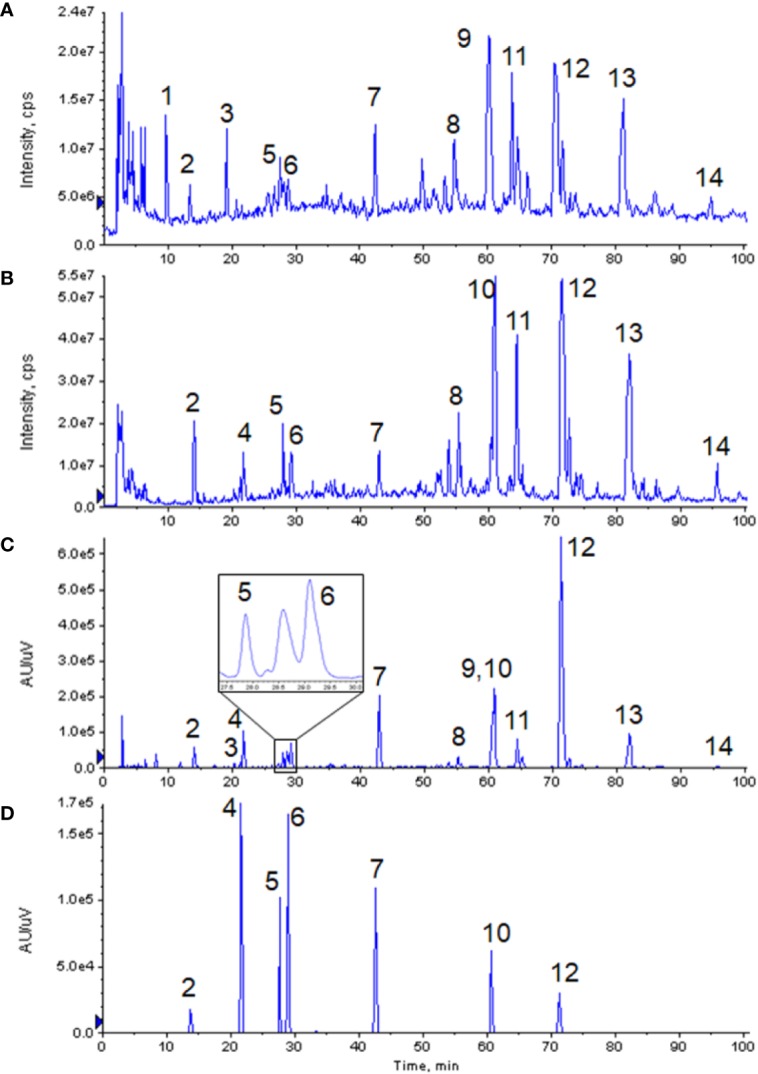
Chromatograms of GXNT and mixed standard. (A) TIC diagram of GXNT mass spectrometry in the positive mode. (B) TIC diagram of GXNT mass spectrometry in the negative mode. (C) Chromatogram of GXNT at 280 nm. (D) Chromatogram of mixed standard at 280 nm. (1) Phenylalanine; (2) Tanshinol; (3) Senkyunolide B; (4) Protocatechualdehyde; (5) Chlorogenic acid; (6) Caffeic acid; (7) Ferulic acid; (8) Salvianolic acid D; (9) Senkyunolide I; (10) Rosemary acid; (11) Isosalvianolic acid A; (12) Salvianolic acid B; (13) Salvianolic acid A; (14) Isosalvianolic acid C.